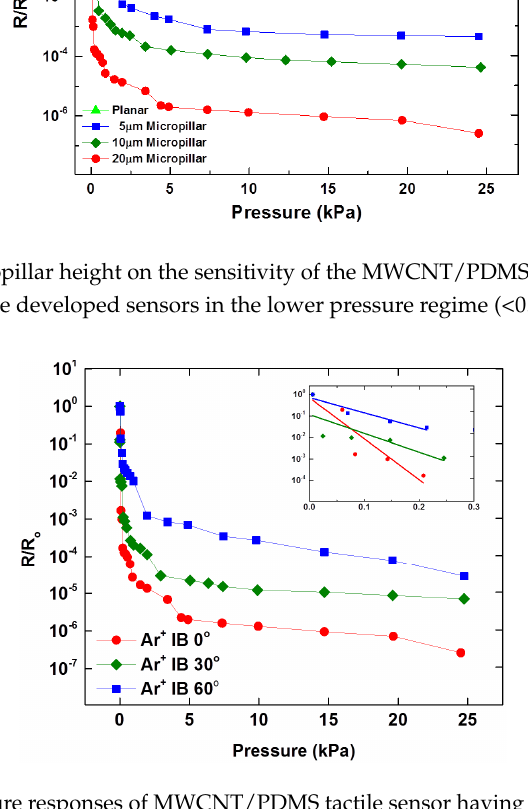
Figure 6. Normal pressure responses of MWCNT/PDMS tactile sensor having 20 μ m high micropillars processed by Ar + ion beam treatment at incident angles of 0°, 30°and 60°. The inset shows the sensitivities of the developed sensors in the lower pressure regime (<0.3 kPa).